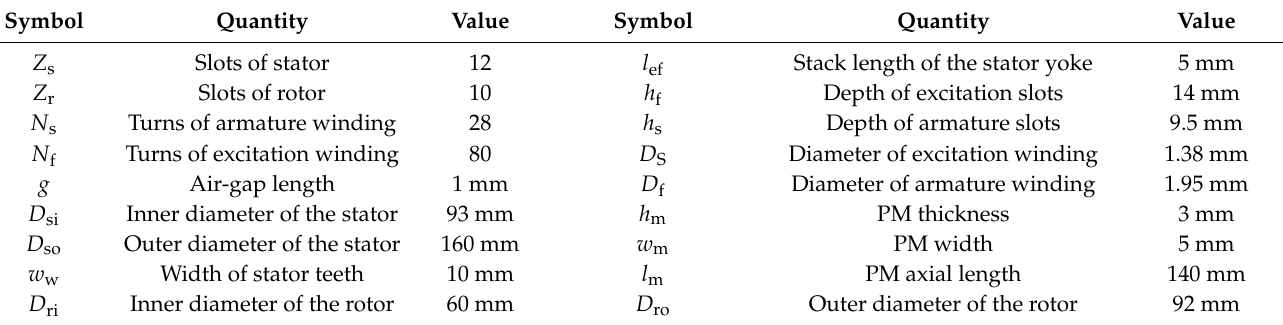
Table 1. Parameters of the studied